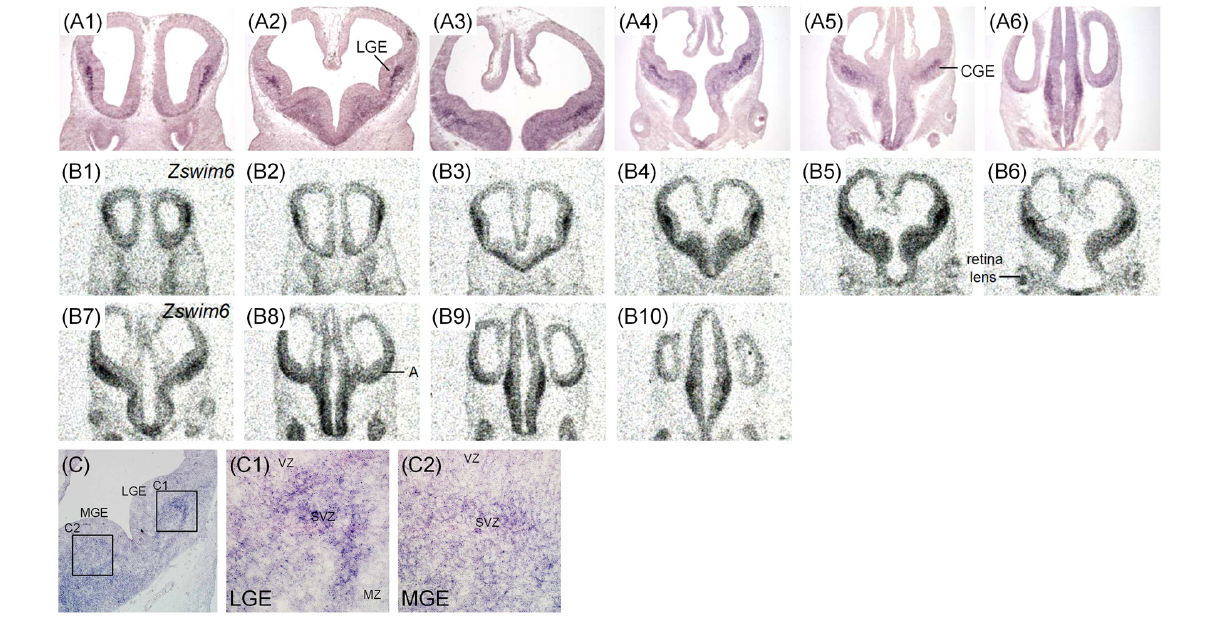
Frontiers in Neuroanatomy |